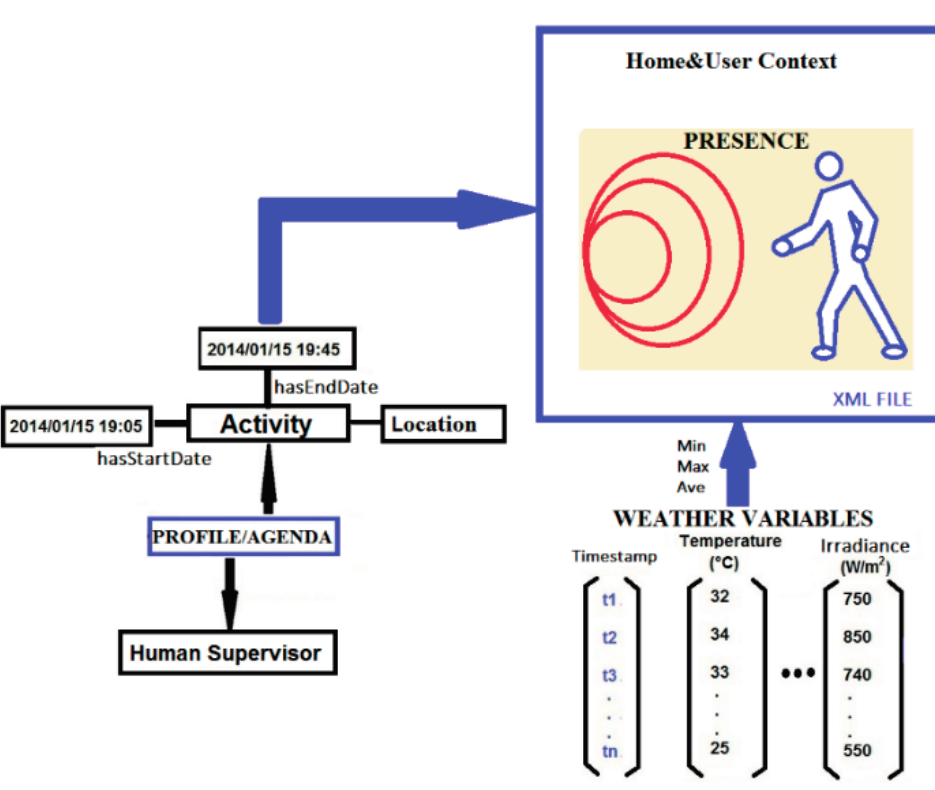
Figure 17. Home&User Context Virtual